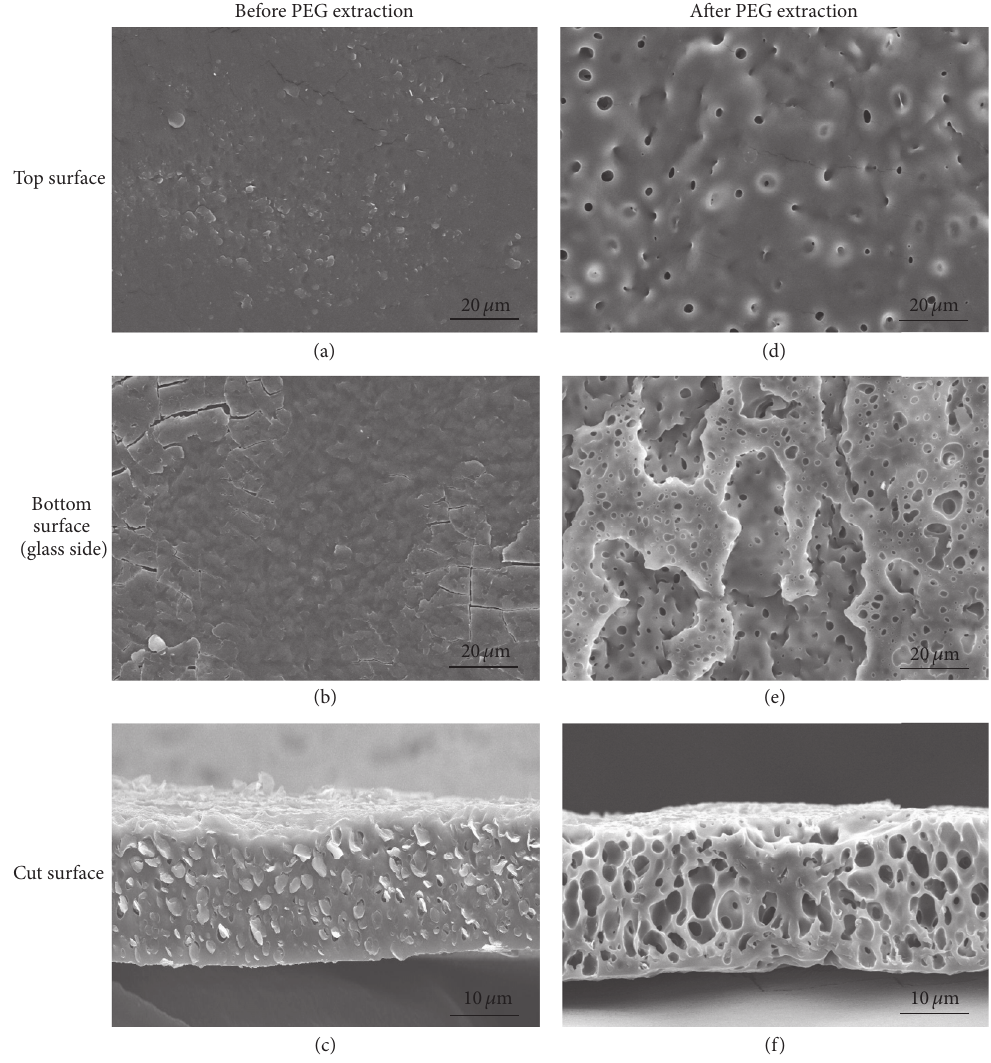
Figure 1: SEM images of 30 PEG-PU films before (a–c) and after PEG extraction